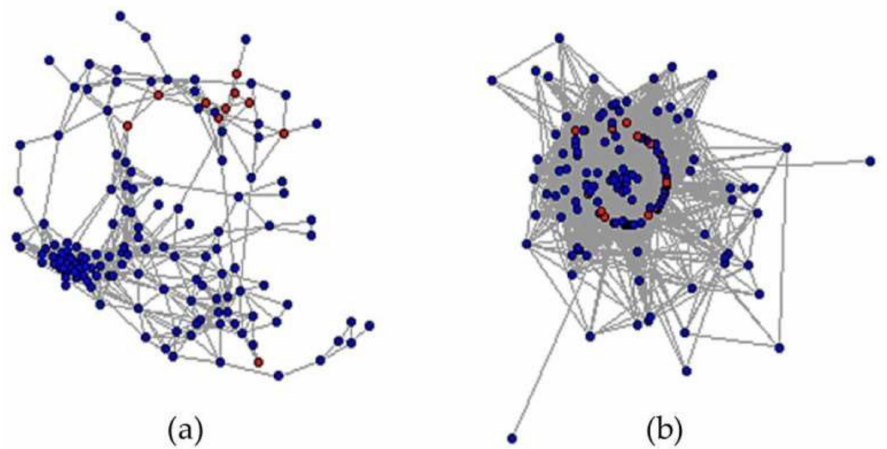
Figure 7. Co-expression networks under different states. Red nodes represent all seventeen candidates while blue nodes represent all of the other nodes. ( a ) Co-expression network of genes under normal situation. ( b ) Co-expression network of genes under salt